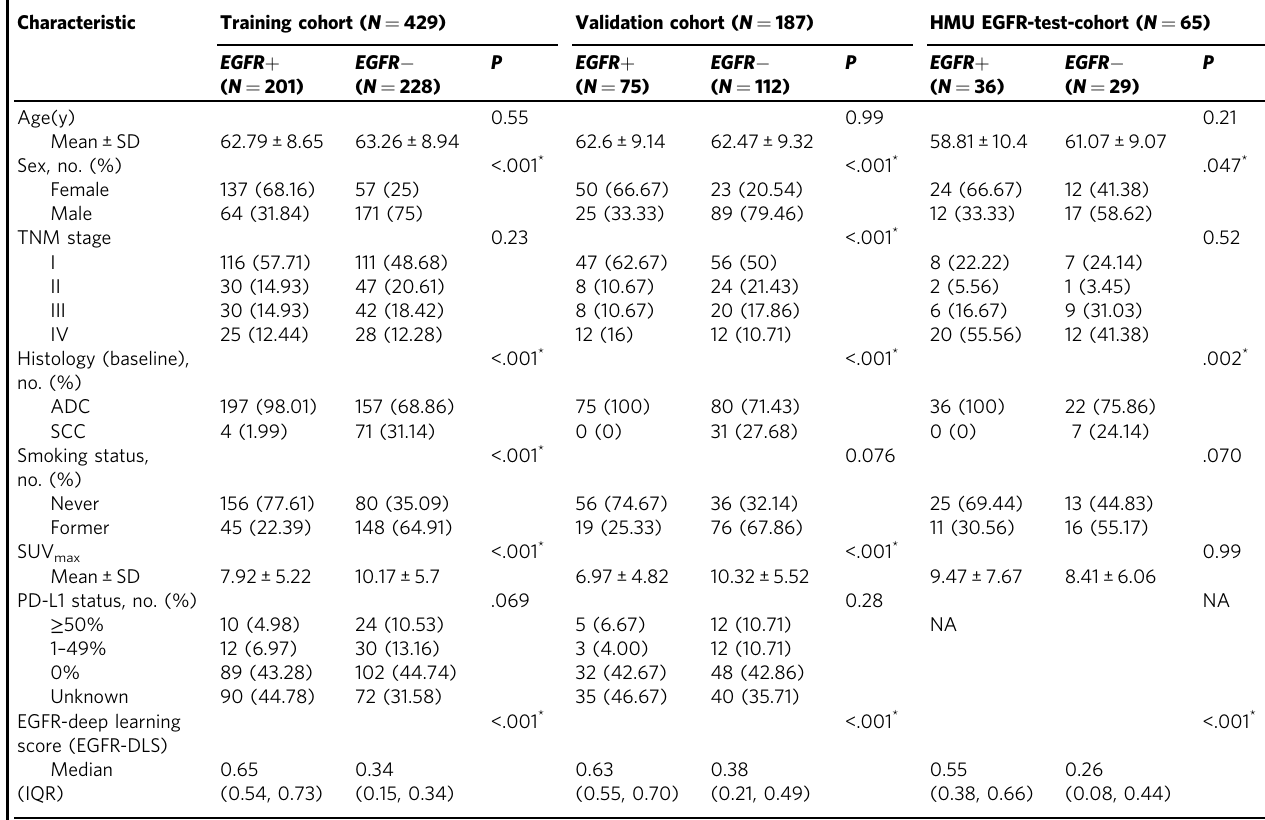
The comparison of age, EGFR-DLS, and SUV max between two groups was performed with two-sided Wikcoxon sign-rank test, and the rest variables were compared with two-sided Fisher ’ s test. IQR is short for interquartile range. ADC is short for adenocarcinoma and SCC is short for squamous cell carcinoma. NA not available. * p Value